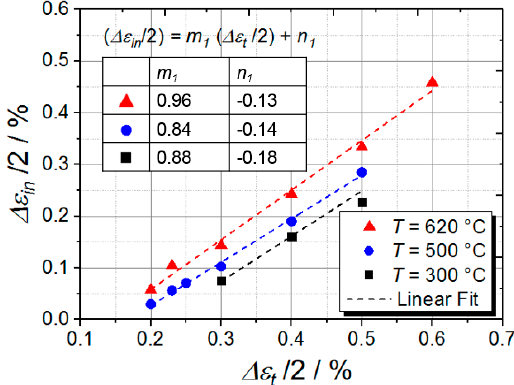
Figure 6. Relation between total strain amplitude and inelastic strain amplitude for the LCF-tests at N = 50% N f.